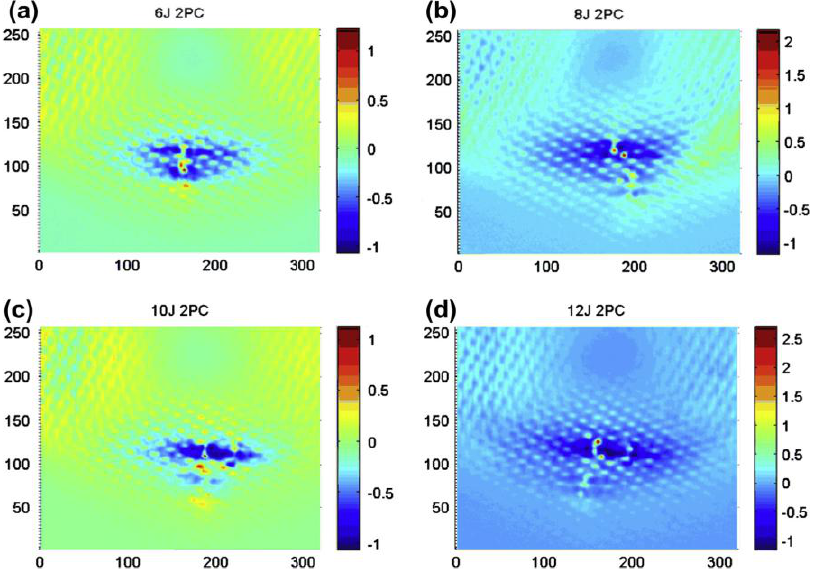
Figure 18. ECST results combined with PCT on a CFRP composite sample impacted at 6 J ( a ); 8 J ( b ); 10 J ( c ) and 12 J ( d ), with permission from